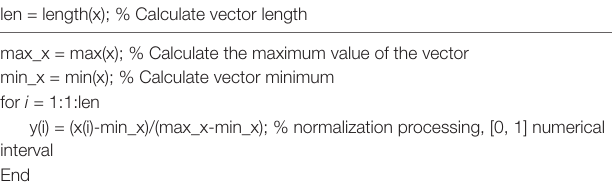
TABLE 3 | HMM-RBF hybrid model